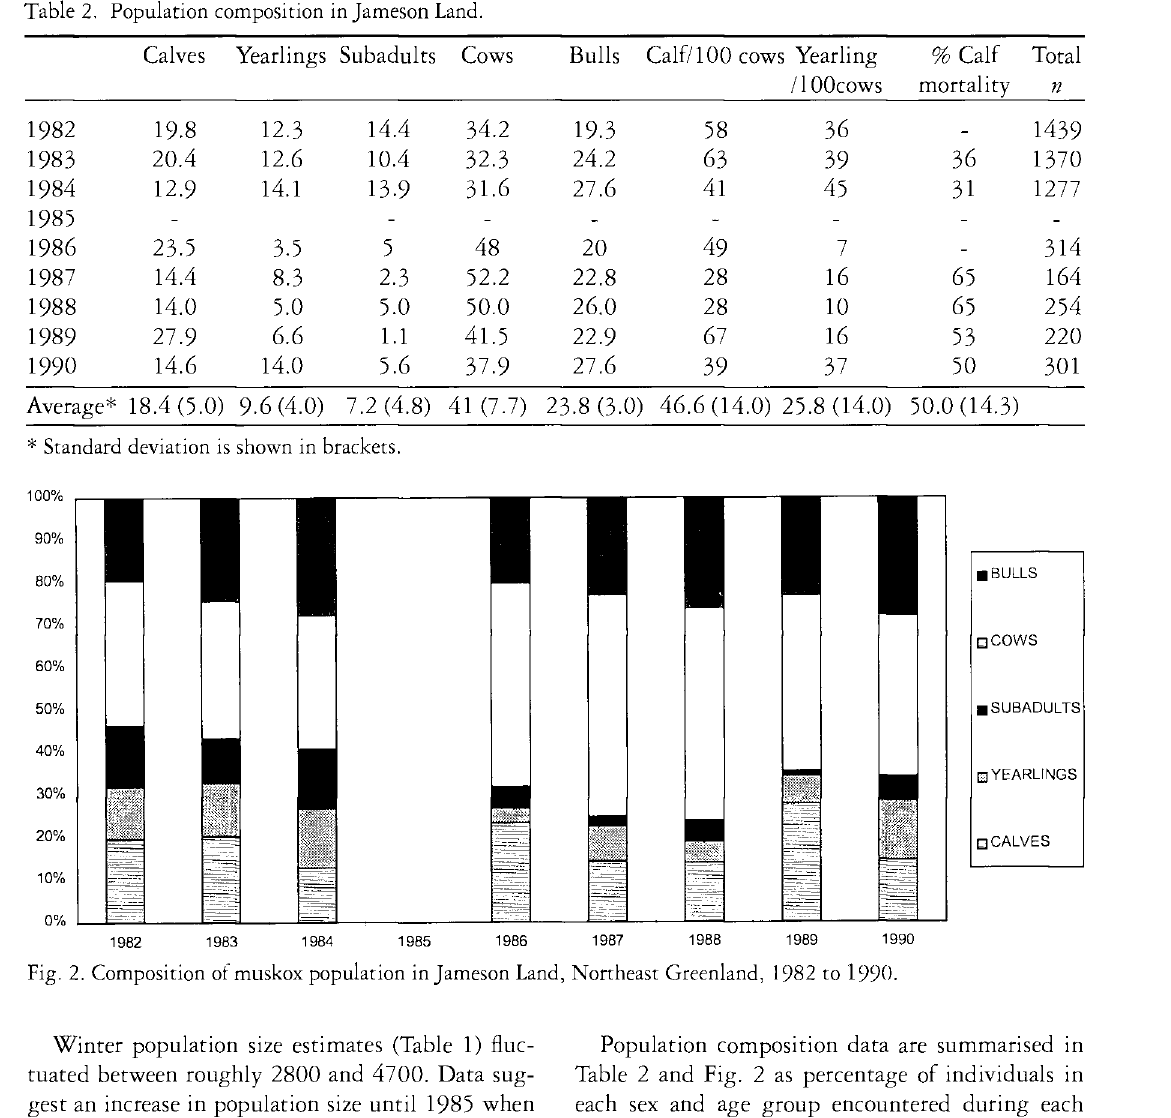
Table 2. Population composition in Jameson Land. Calves Yearlings Subad ults Cows Bulls Calf/100 cows Yearling % Calf